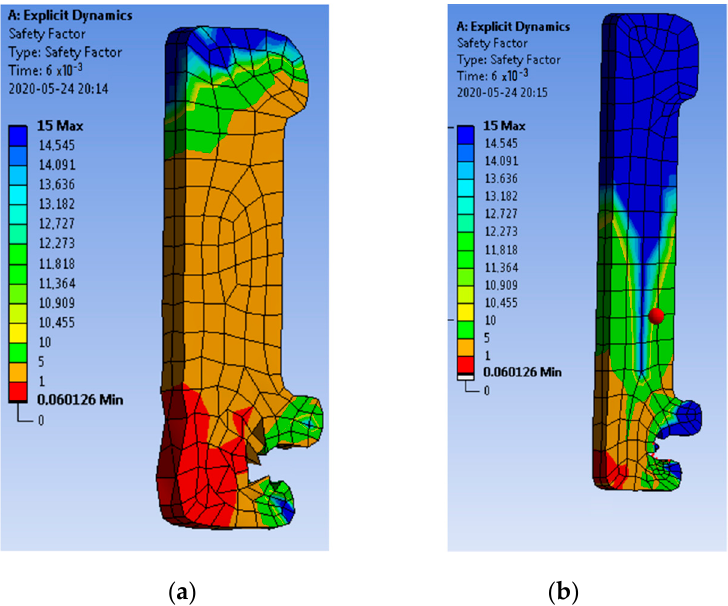
Figure 10. View of the lamellas used in the tulip contact: ( a ) Small (external) lamella in the deformation value view and ( b ) large (internal) lamella in the deformation view.